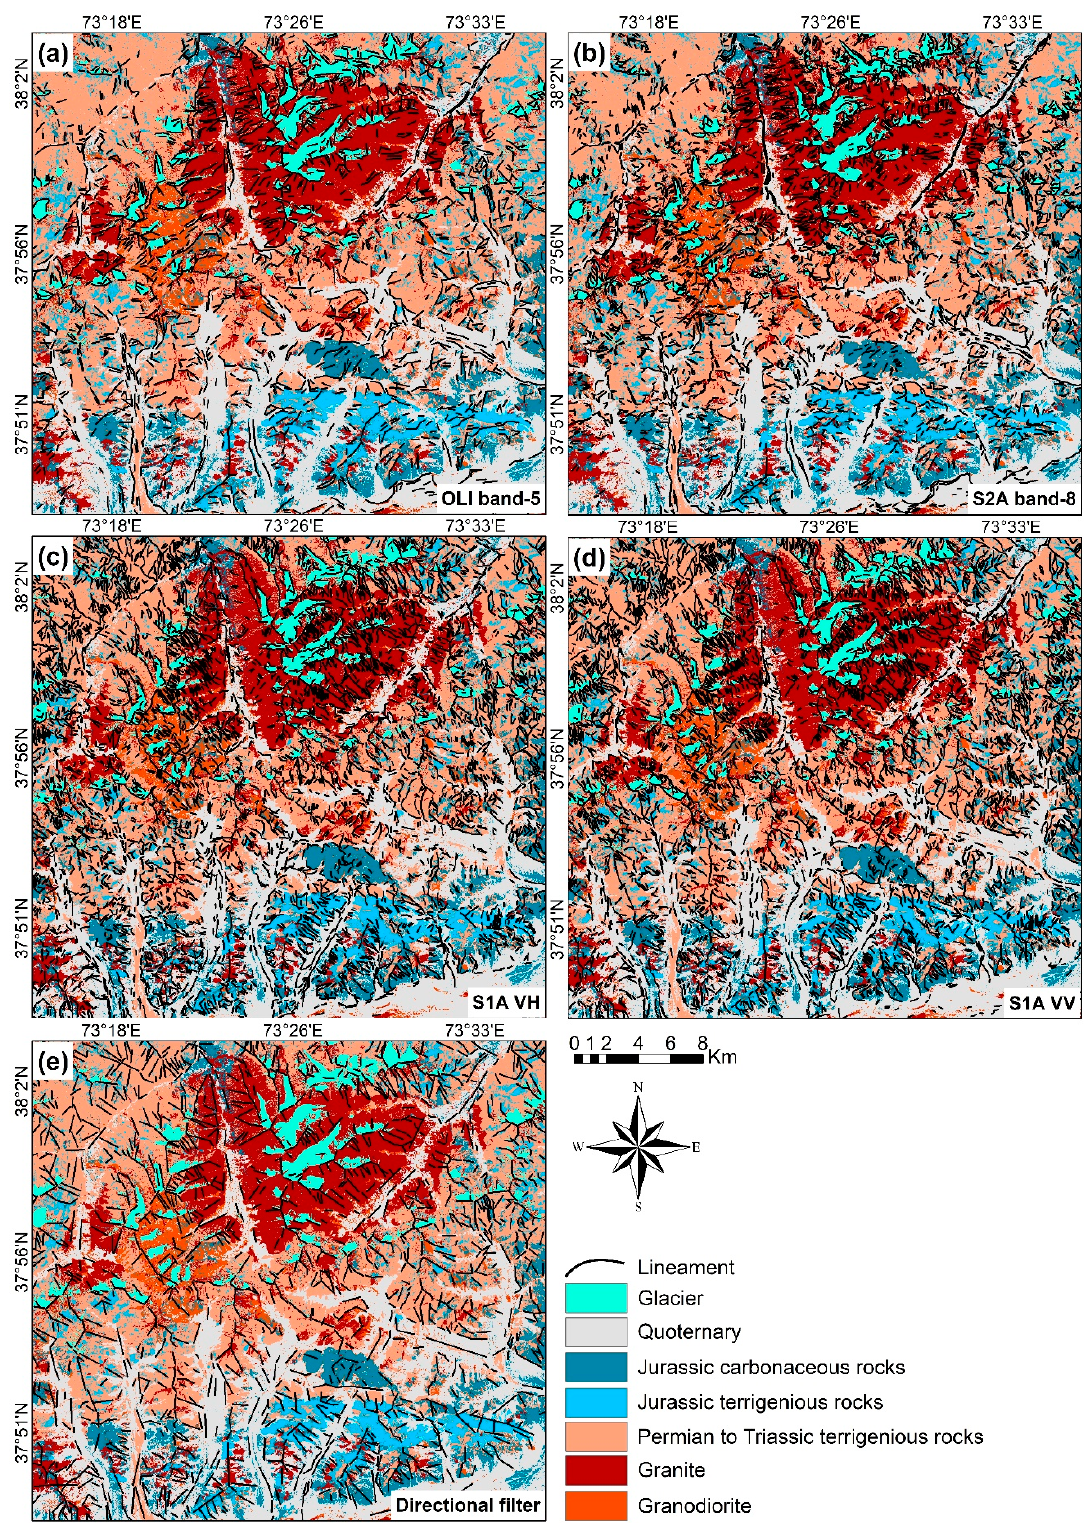
Figure 9. The superposition of lineaments extracted automatically from ( a ) OLI band-5, ( b ) S2A band-8, and ( c , d ) S1A VH and VV polarizations respectively, in addition to the ( e ) lineaments extracted manually from the directionally filtered RGB color composite image on the Lithologic map [37].